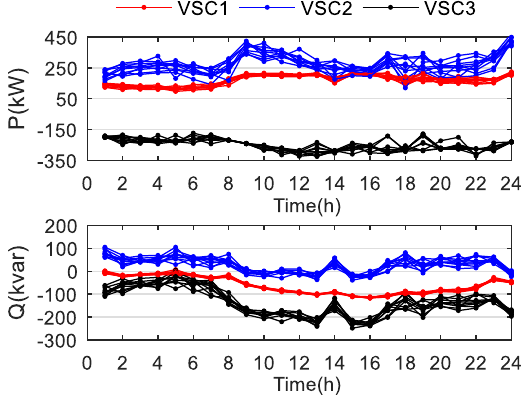
Figure 8. The transferred active and reactive power by voltage source converter in Case 4.